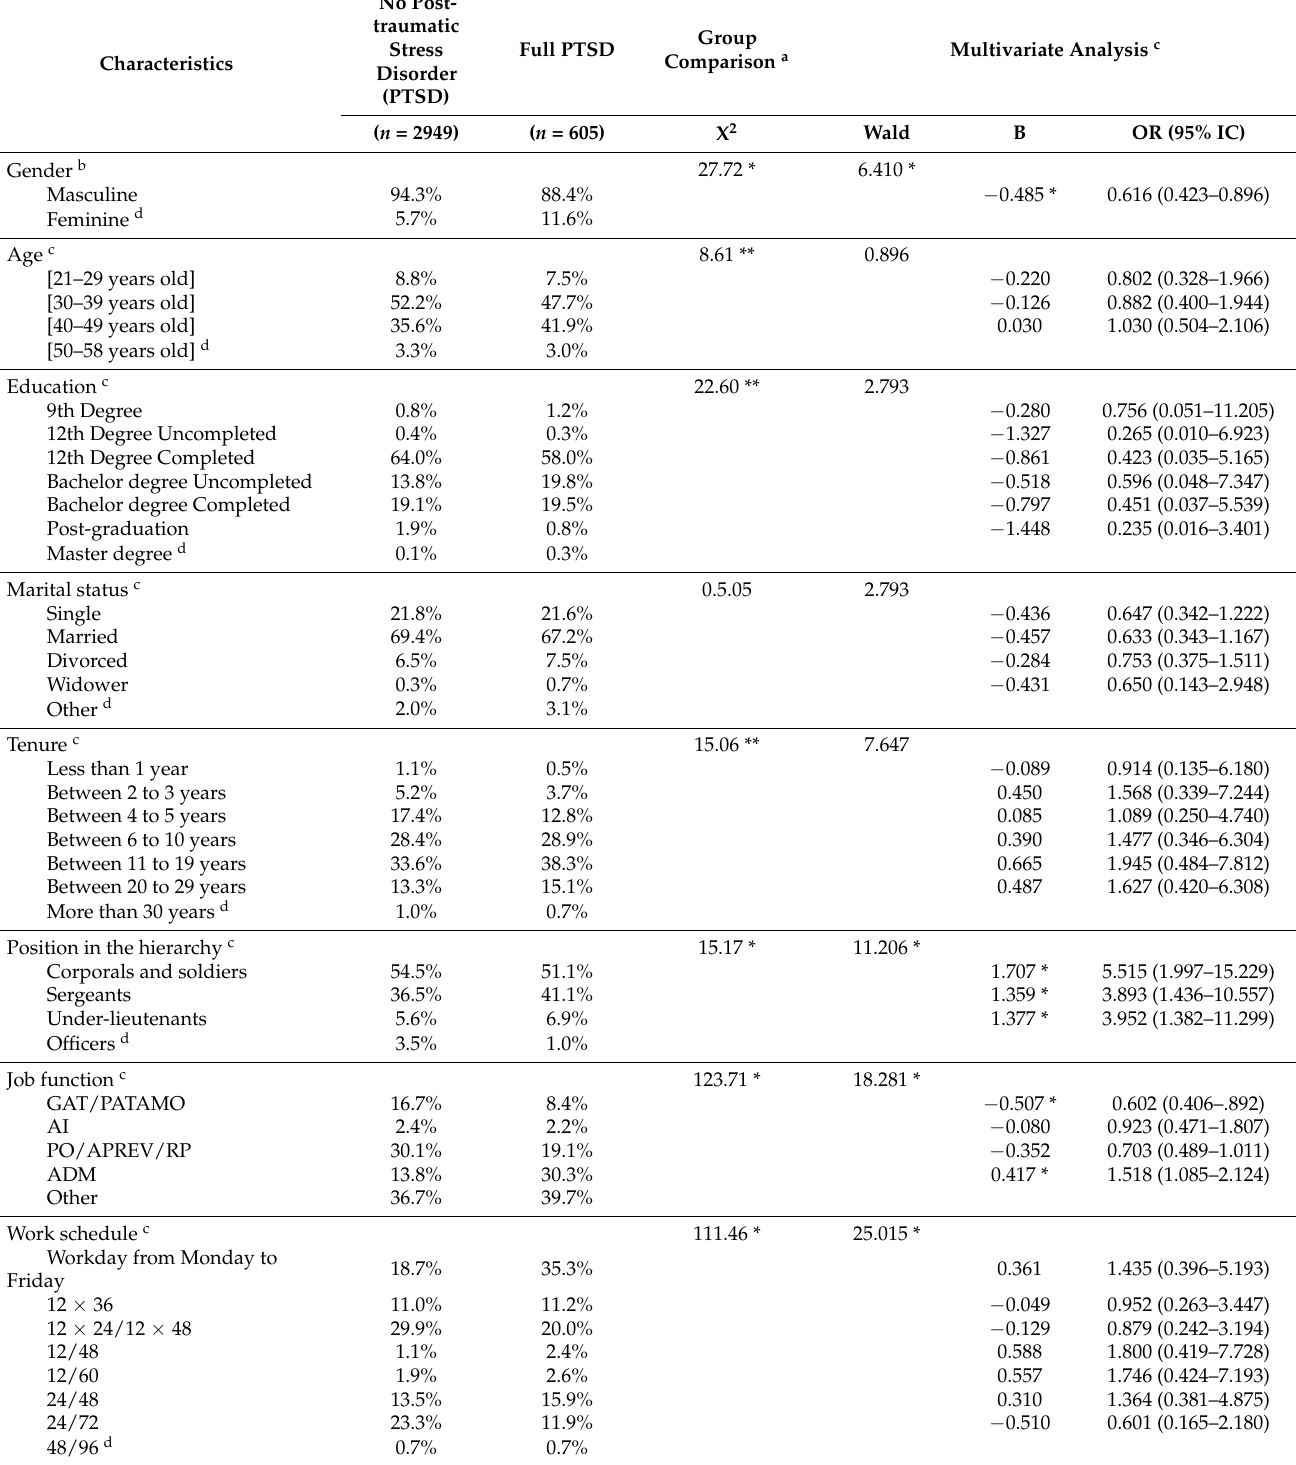
Table 1. Relationships among post-traumatic stress symptoms status and socio-demographic and work-related variables.